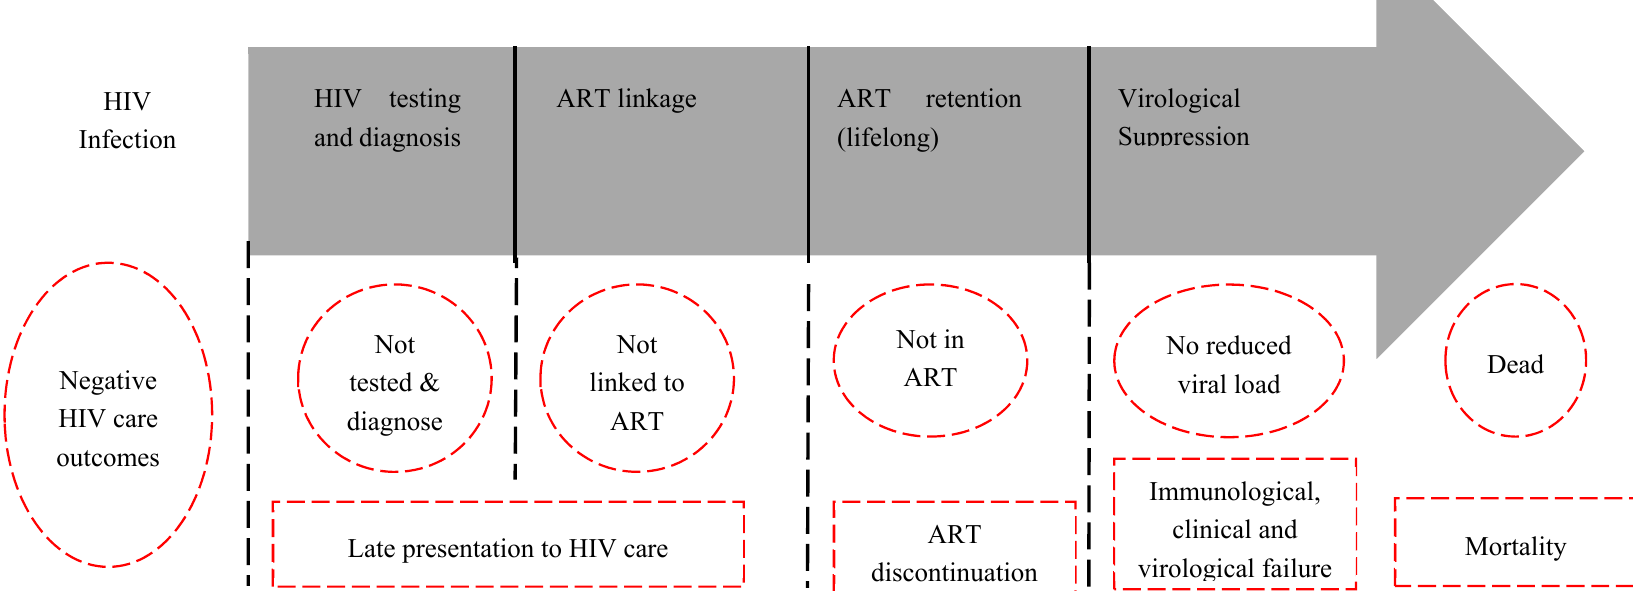
Figure 1. HIV care framework for assessing negative outcomes of HIV care and treatment, Southwest Ethiopia, 2018 (Adapted based on Kranzer et al., 2012) [8]. The box with the grey arrow shows the steps on the pathway of HIV care: HIV testing and diagnosis, ART linkage, lifelong ART retention and virological suppression. The dotted lines, circles or rectangles in red outside the grey arrow show negative outcomes in the pathway of HIV care: late presentation for HIV care, ART discontinuation, immunological, clinical or virological failure, and mortality.